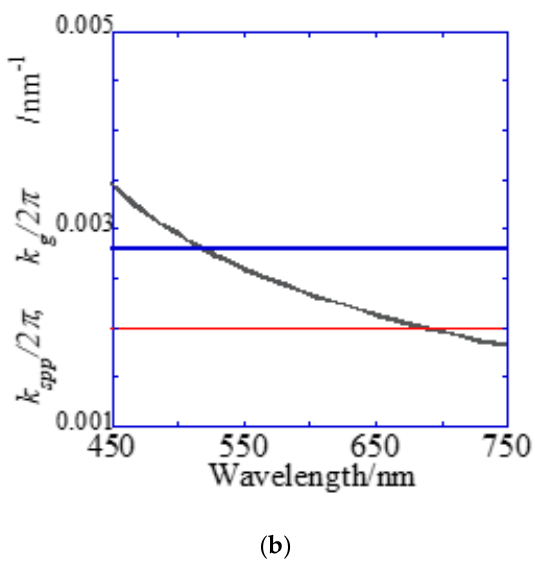
Figure 7. Reflection spectra and resonance wavelengths calculated from the resonance condition. ( a ) Reflection spectra measured by microspectroscopy. Two dips were confirmed at the position of the theoretically expected resonance wavelength. ( b ) The resonance wavelength at the water interface in a 500 nm pitch hole-arrayed plasmonic chip. The blue and red solid lines indicate k gx ( 1 ) and k gx 45 ( 2 ) , respectively, and the intersection of the blue and red solid lines with the k spp curve are the theoretical resonance wavelength.